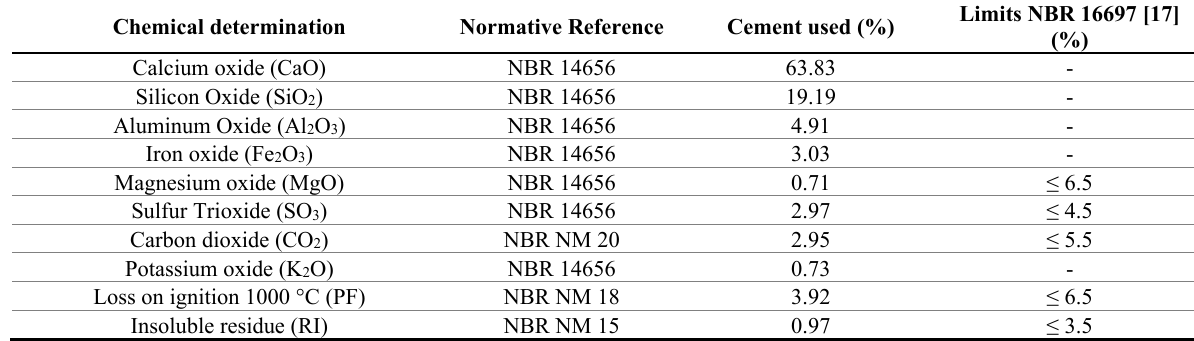
Table 2. Chemical characterizations of the cement used. Chemical